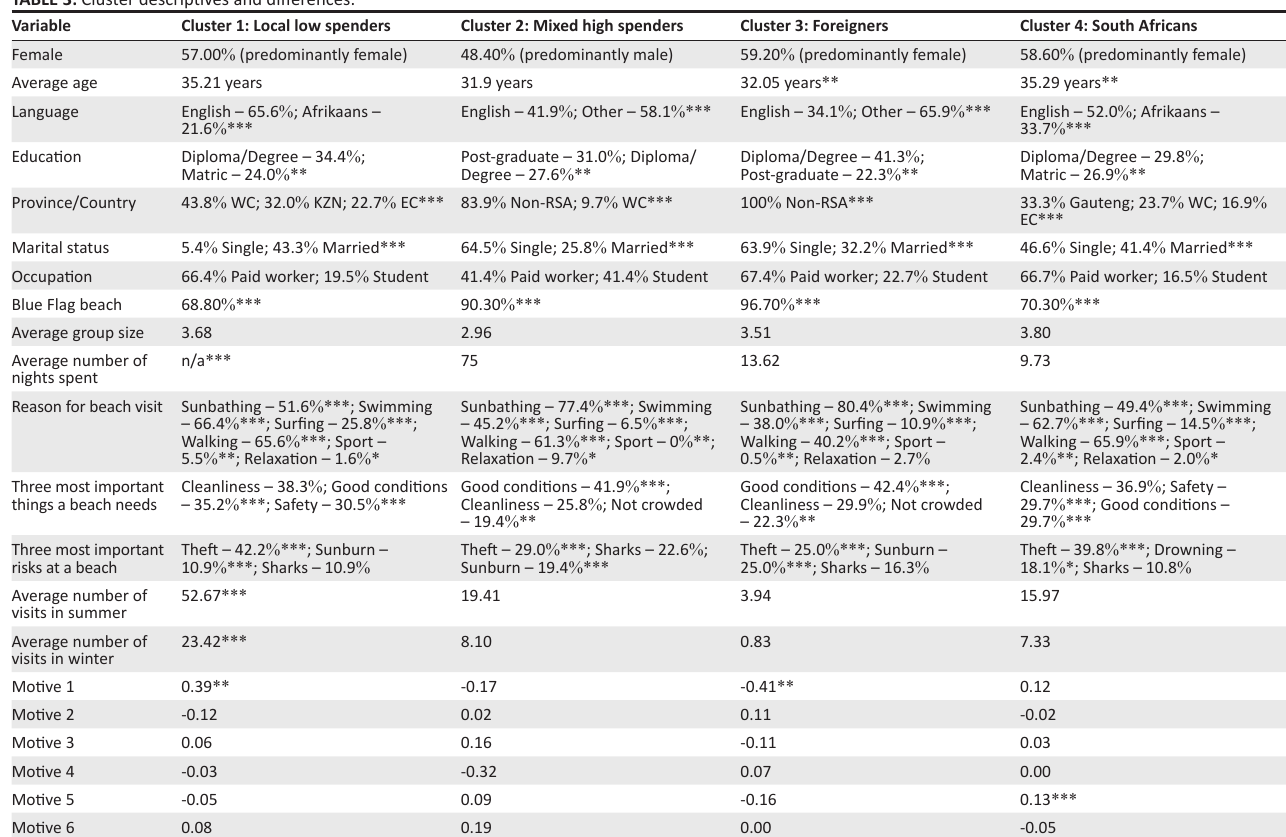
TABLE 3: Cluster descriptives and differences.